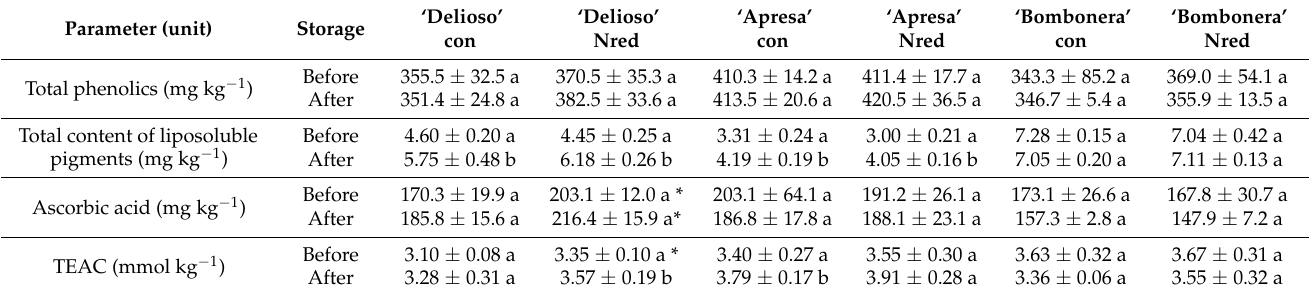
Table 5. Mean and standard deviation of the antioxidant status of fruits of three cocktail tomato varieties grown with normal (con) and reduced (Nred) N supplies, immediately after harvest (before storage) and after 8 days of storage at 12 ◦ C (after storage). The antioxidant parameters are expressed on a fresh weight base. N = 3–4. Different letters indicate significant differences due to storage within a variety and N supply. Asterisks indicate significant differences due to N supply within a variety and storage (Two-Way ANOVA with Tukey pairwise comparison, or Kruskal-Wallis test with Mann-Whitney pairwise comparison; at α = 0.05).